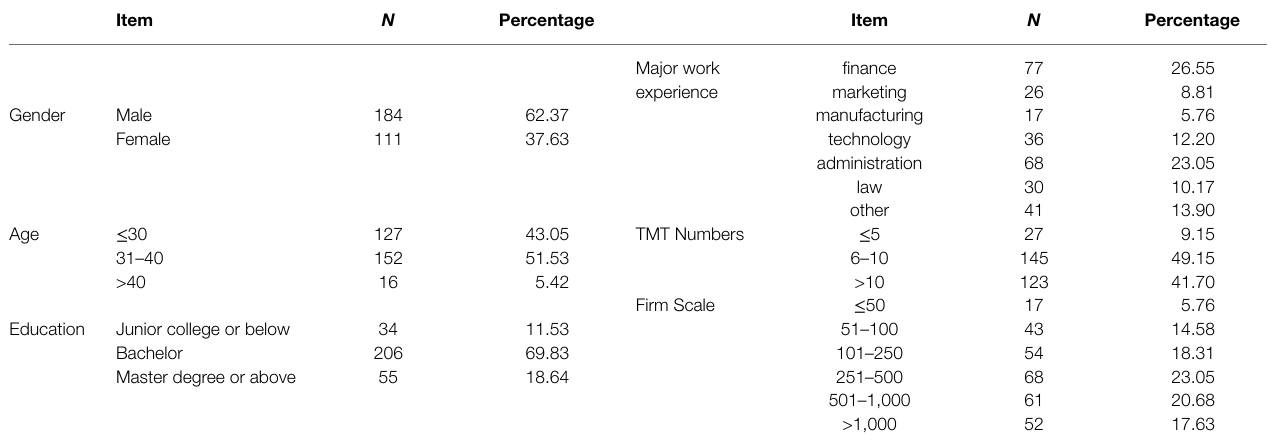
TABLE 1 | Sample feature distribution ( N = 295).